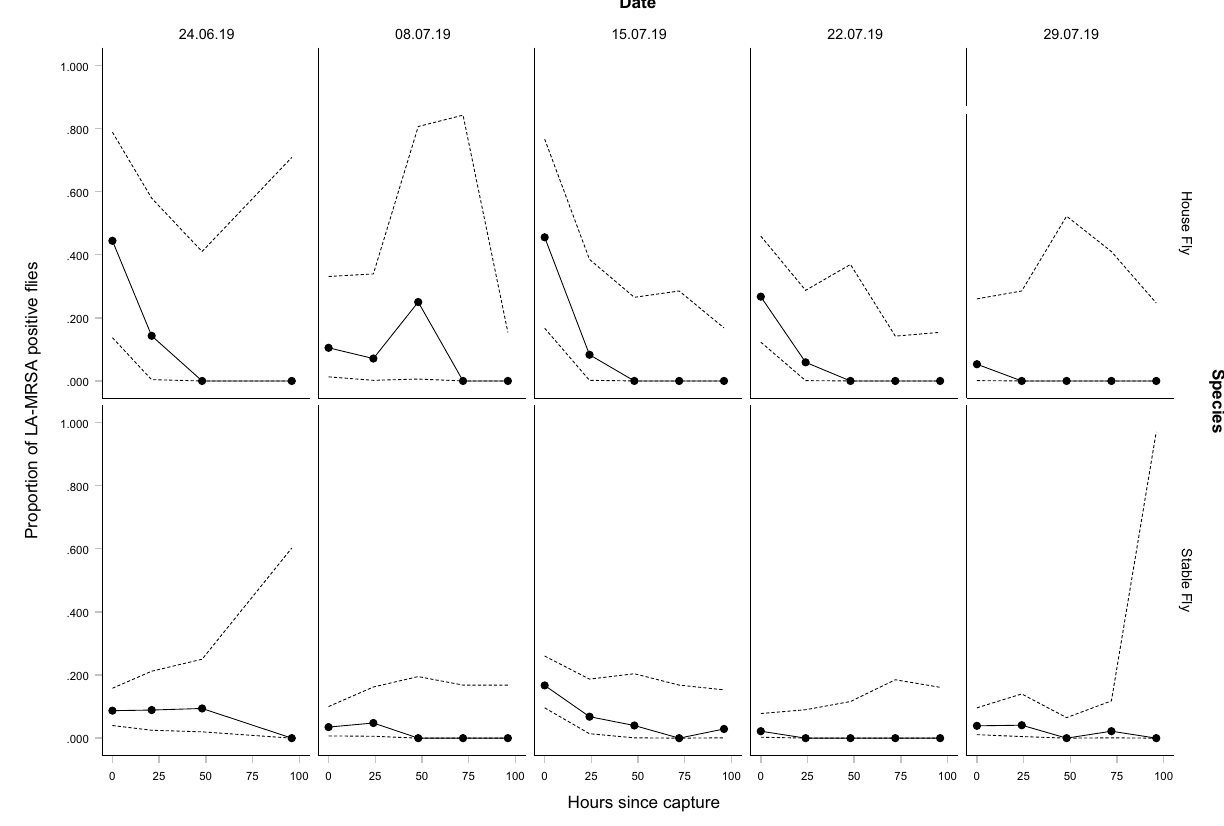
Figure 1. The proportion of house flies and stable flies that tested positive for LA-MRSA from each sampling container and their binomial proportion confidence intervals (95%). The average proportion of LA-MRSA positive house flies (H) and stable flies (S) is 0.2648 (H, n = 18) and 0.07 (S, n = 94) after 0 h, 0.0712 (H, n = 12) and 0.0492 (S, n = 44) after 21/24 h, 0.05 (H, n = 7) and 0.0268 (S, n = 32) after 48 h, 0 (H, n = 11) and 0.0055 (S, n = 26) after 72 h, 0 (H, n = 16) and 0.0058 (S, n = 23) after 96